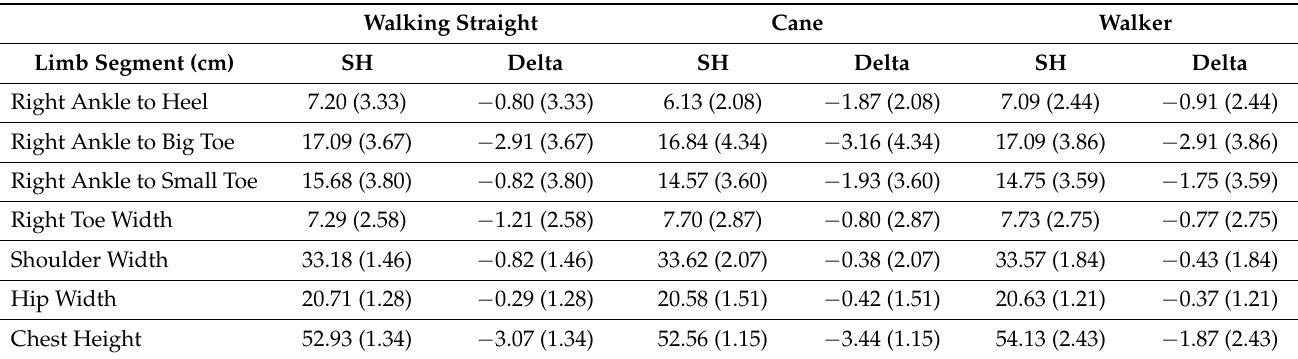
Table A6. Cont. Walking Straight Cane Walker